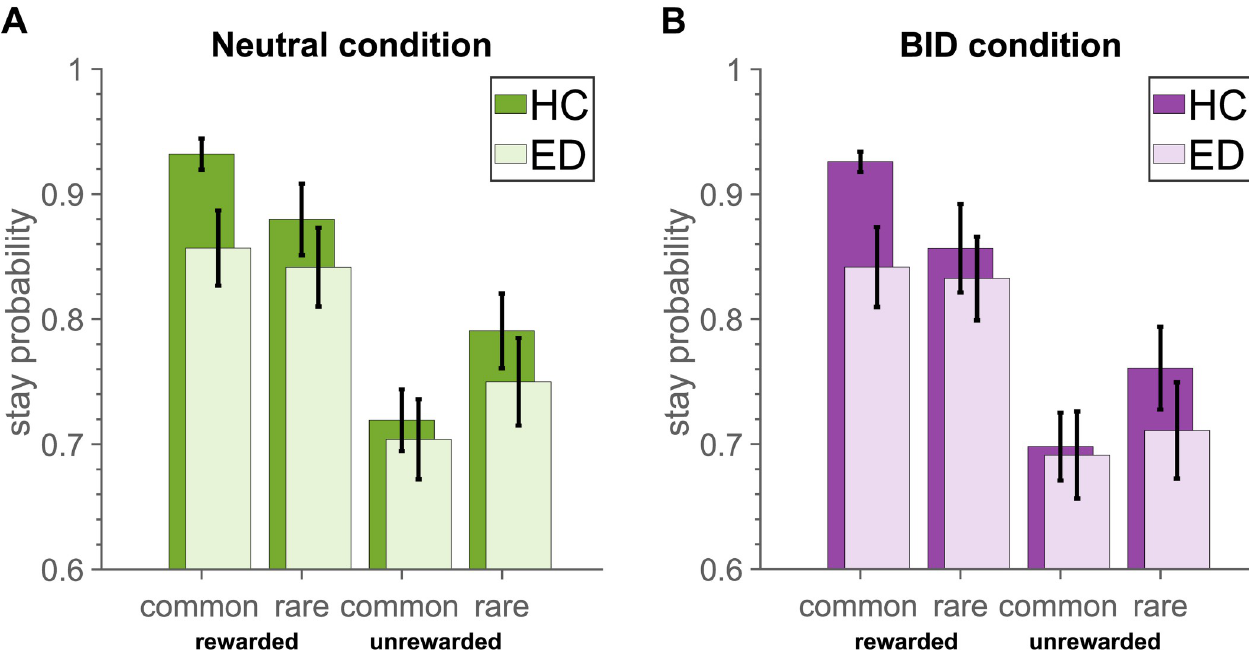
Fig 4. Stay probabilities in the collected data. (A) Neutral condition. (B) BID condition.